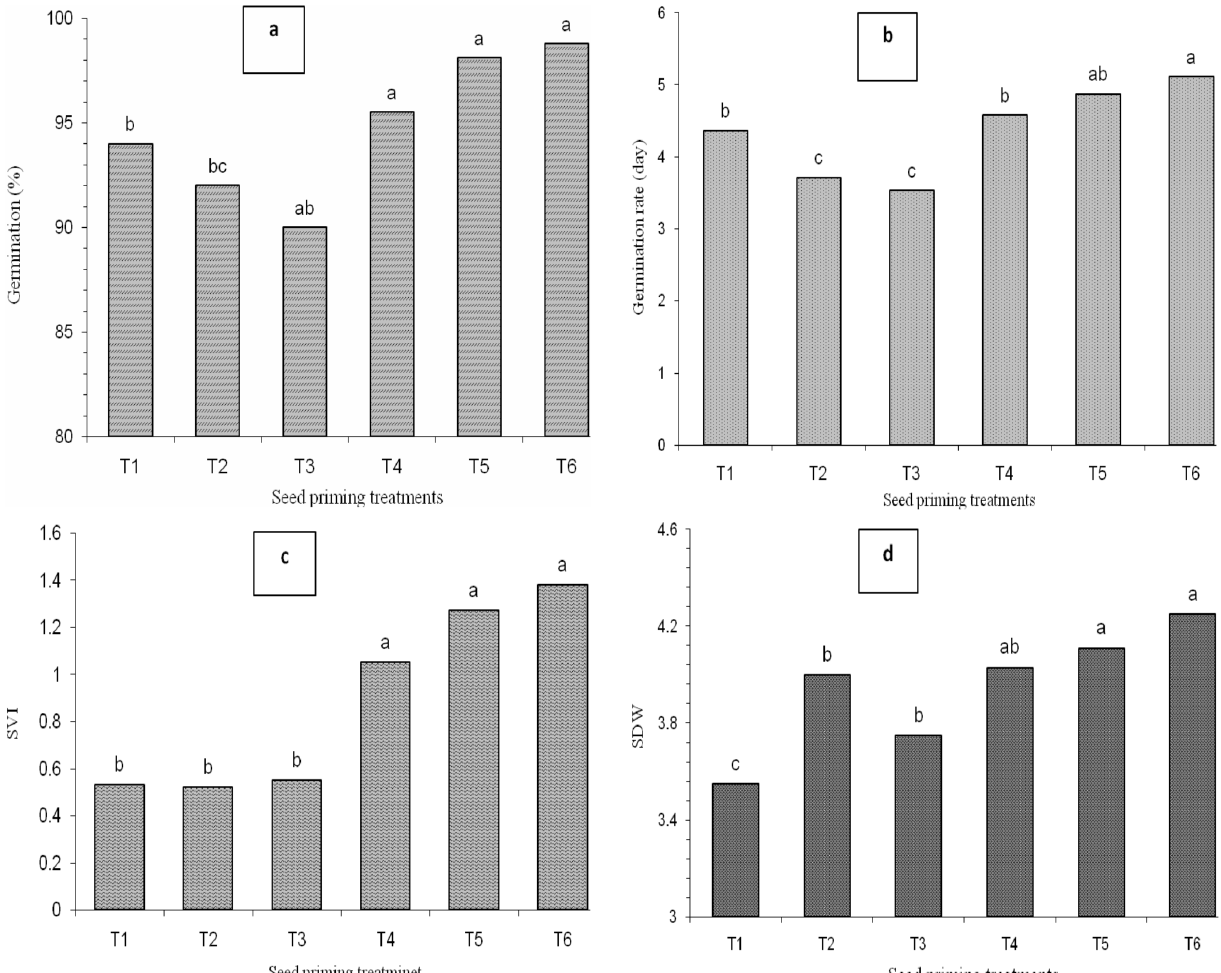
Fig. 1. Effect of priming on germination properties of cowpea seeds in laboratory; (a) Germination percentage; (b) Germination rate; (c) Seed vigor index (SVI); (d) Seedling dry weight (SDW). T tively; T , T and T : Hydropriming of 8, 12 and 16 hours 4 5 6